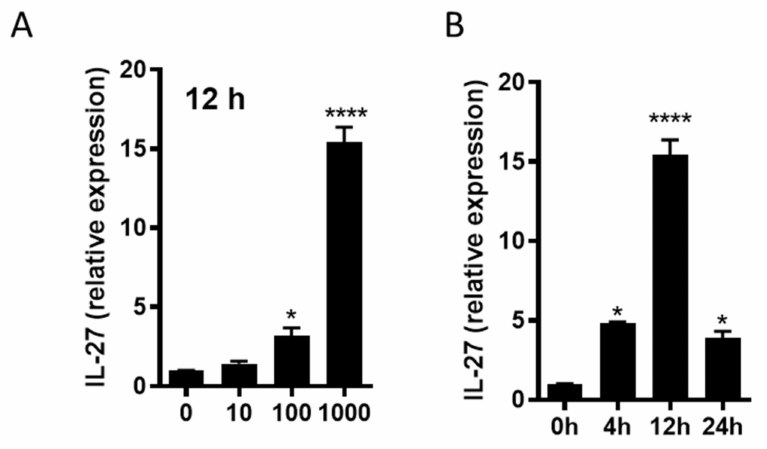
Figure 8. SlpA leads to increased expression of IL-27 in murine dendritic cells. Murine bone marrow cells were differentiated into dendritic cells using GM-CSF. ( A ) Murine dendritic cells were incubated with increasing concentration of purified SlpA (0, 10, 100, and 1000 ng/ml) for 12 h. ( B ) Murine dendritic cells were exposed to 1000 ng/ml of purified SlpA for 4, 12, and 24h. Total RNA was isolated and converted to cDNA and used as template for the evaluation of the IL-27 transcript. GAPDH was used as endogenous control; n = 3; * p < 0.05; **** p <